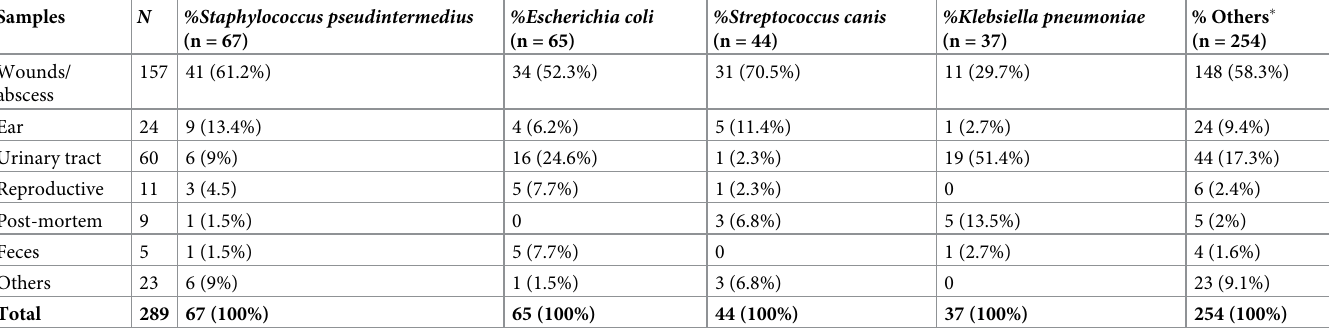
Table 1. Species of bacteria isolated from diagnostic samples from diseased cats received by the Bacteriology Laboratory between 2015 and 2017. Samples